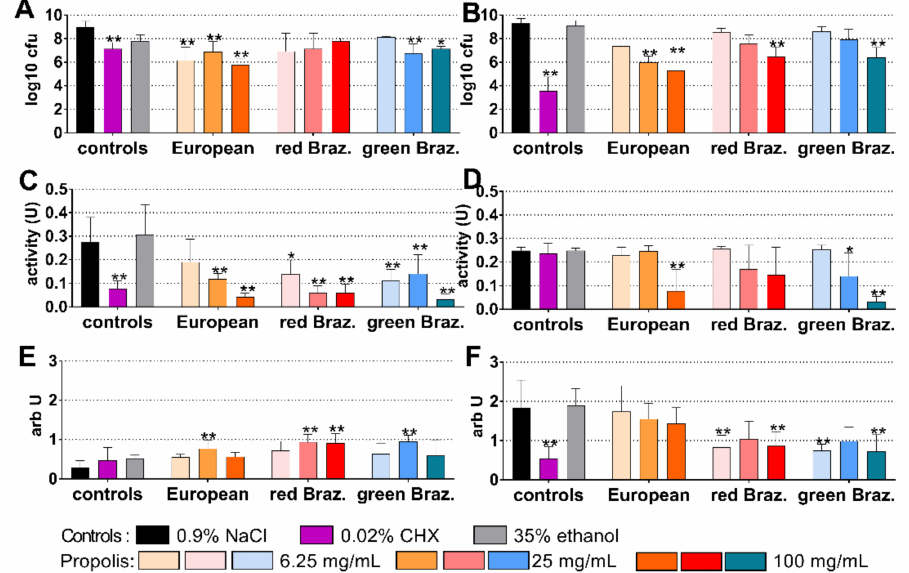
Figure 5. Activity of the different ethanolic extracts of propolis (European and red and green Brazilian (Braz.)) on colony forming unity (cfu) ( A , B ), metabolic activity ( C , D ), and quantity ( E , F ) in a formed periodontal biofilm after 4 h ( A , C , E ) and 24 h ( B , D , F ). */** p < 0.05/ p < 0.01 vs. control 0.9% NaCl. The metabolic activity decreased after the application of 0.02% CHX ( p = 0.010) and of all EEPs except for 6.25 mg/mL propolis of the European EEP at 4 h (Figure 3B). At 24 h, the activity was reduced by 100 mg/mL propolis of the European EEP, as well as by 25 mg/mL ( p = 0.025) and 100 mg/mL propolis ( p < 0.001) of the green Brazilian EEP (Figure 5E). At 4 h, the quantity of biofilm increased in part after the addition of the EEPs (Figure 5C). At 24 h, there was a reduced quantity after 0.02% CHX ( p < 0.001) and 6.25 mg/mL ( p = 0.001; p = 0.003) and 100 mg/mL ( p = 0.001; p = 0.006) propolis of the European EEP and